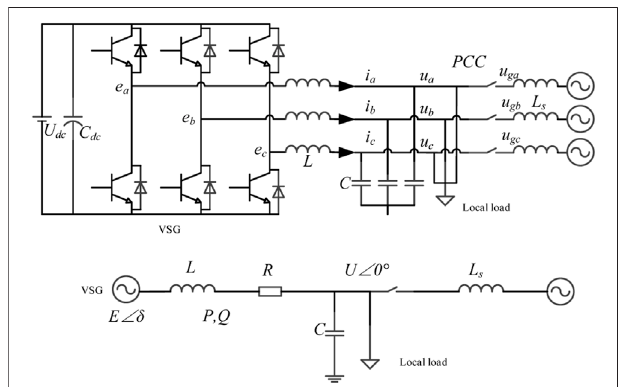
FIGURE 1 | The topological graph of